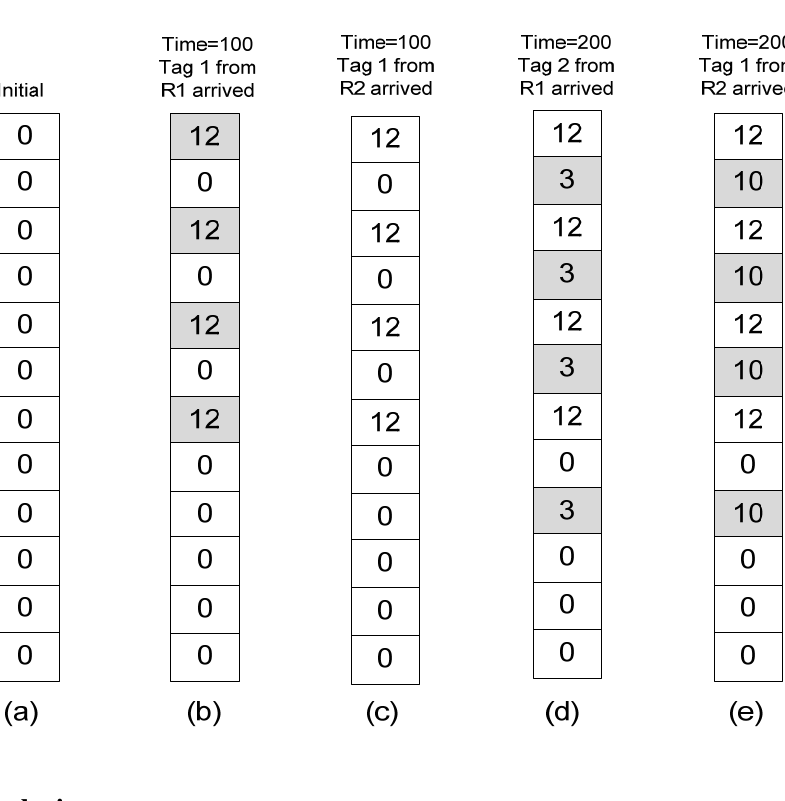
Figure 3. The state of CBF based readings in Table